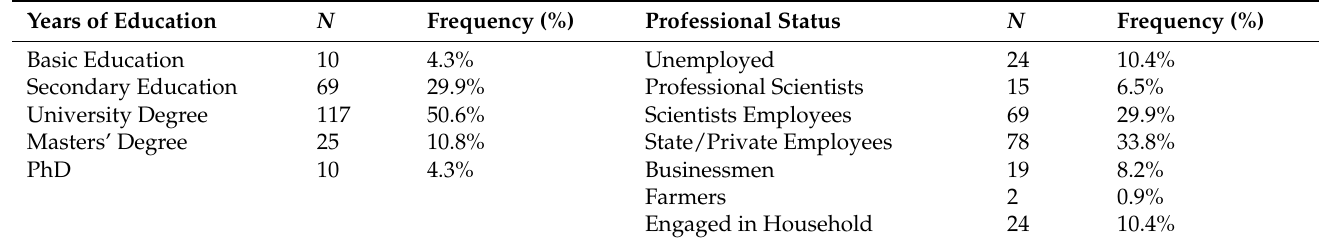
Table 1. Educational and professional profile of